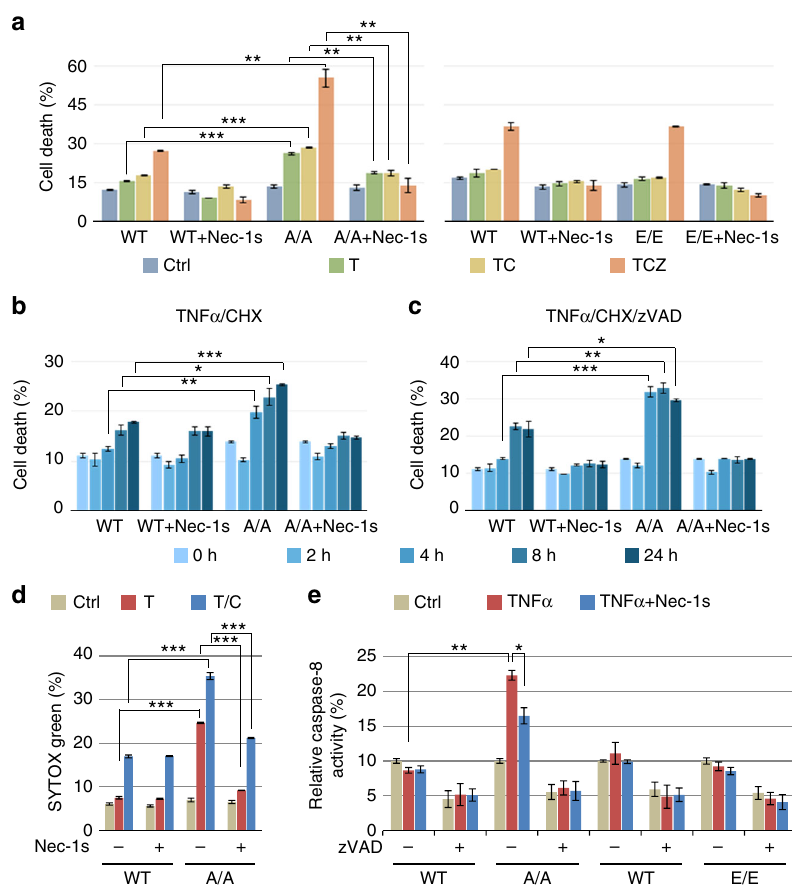
Fig. 5 RIPK1 S321A mutation sensitizes cells to RIPK1-dependent cell death. a – c RIPK1 S321A(A/A) but not S321E(E/E) MEFs are more sensitive to RIPK1- dependent cell death. Immortalized MEFs generated from littermates of WT and RIPK1 S321A(A/A), or WT and S321E (E/E) were treated with TNF α (10 ng/ml), CHX (0.5 µ g/ml), zVAD (20 µ M) and Nec-1s (10 µ M) as indicated. Cell death was measured by ToxiLight assay after 16 h treatment a or at indicated time-points b , c and normalized to TX-100-treated cells. d TNF α alone or TNF α /CHX induces RDA in RIPK1 S321A(A/A) mutant MEFs. WT and RIPK1 S321A(A/A) MEFs were treated with TNF α (10 ng/ml) or CHX (0.5 µ g/ml) with or without Nec-1s (10 µ M) for 24 h. After SYTOX Green staining, fl uorescence intensity was quanti fi ed and normalized to TX-100-treated cells. e TNF α induces caspase-8 activation in RIPK1 S321A(A/A) mutant but not in WT and S321E(E/E) mutant MEFs. The MEFs were treated with TNF α (10 ng/ml) with or without Nec-1s (20 µ M) for 24 h and caspase-8 activity was measured in the presence or absence of zVAD as described in Methods. Error bar, s.e.m. *, t -test P < 0.05; ** P < 0.01, *** P < 0.001. Three independent repeats were included in each data